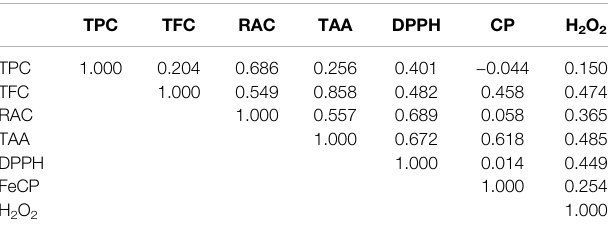
TABLE 5 | Coef fi cients of correlation between the antioxidant compounds [contents in total phenolic (TFC), total fl avonoids (TFC), and rosmarinic acid (RAC)] and antioxidant activities [total antioxidant activity (TAA), DPPH assay, Iron Chelating Power (FeCP), and H 2 O 2 assay] of Mentha samples collected from different regions of